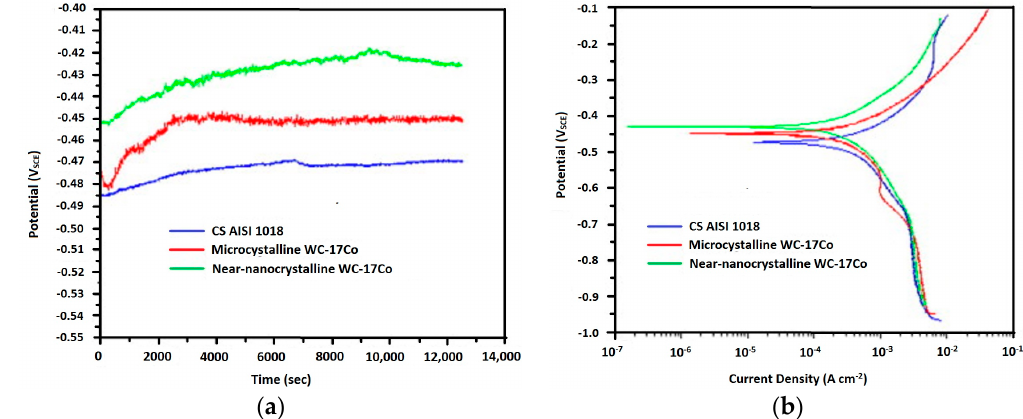
Figure 8. Time dependence of corrosion potential ( a ) and Potentiodynamic polarization curves ( b ) for WC–17Co coated and uncoated steel exposed to fluid flow sand particles in 3.5 wt. % NaCl + 1000 ppm (~0.001 wt. %) NaHCO 3 solution [114]. Reprinted with permission from ref [114]. © 2011 Elsevier.